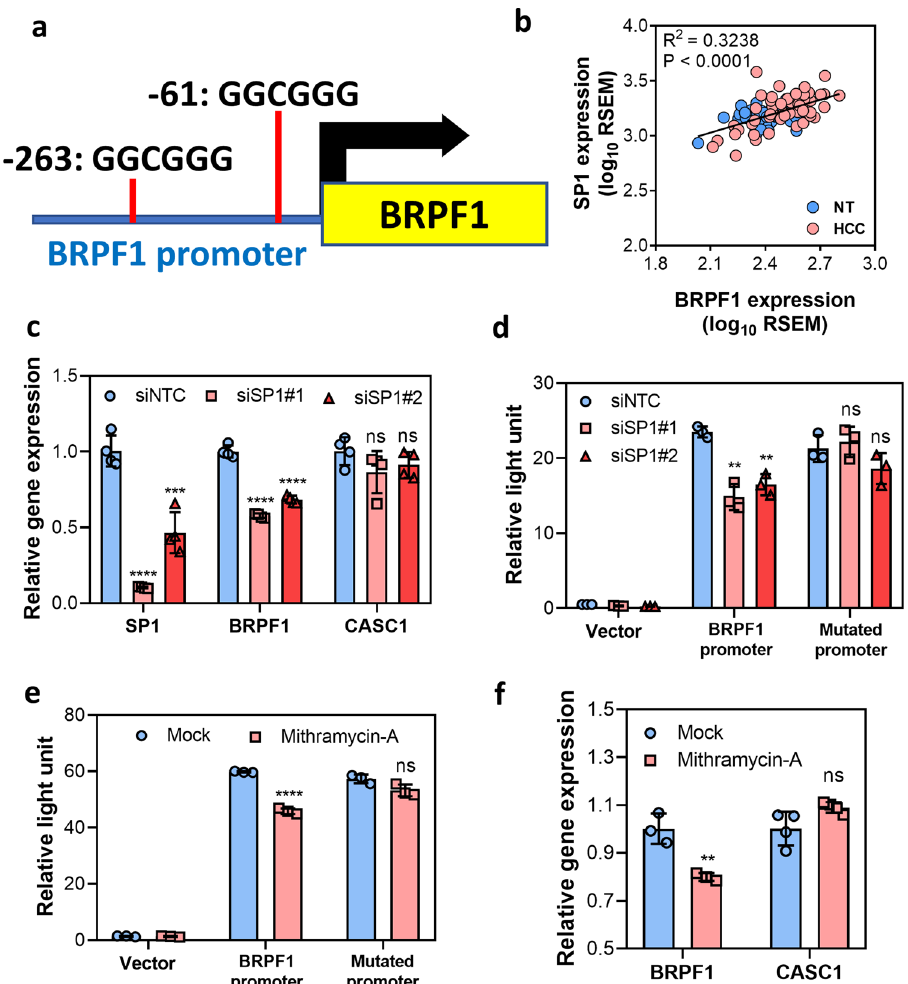
Fig. 3 SP1 upregulation facilitated the increase in BRPF1 expression. a The BRPF1 promoter contains two SP1 putative binding sites. b The expression of SP1 was positively correlated with the expression of BRPF1 in TCGA HCC cohort ( R 2 = 0.3238, P < 0.0001, linear regression, n = 50). c Inactivation of SP1 by siSP1 reduced the mRNA expression of BRPF1 and SP1 in HEK293T cells, while the expression of CASC1, a non-SP1 target, remained unchanged. d Treatment with siSP1 decreased BRPF 1 promoter activity, but not the activity of SP1 binding site mutated BRPF1 promoter in HEK293T cells. e 20 nM mithramycin A, a SP1 inhibitor, reduced BRPF1 promoter activity in HEK293T cells after 48-h treatment. f 20 nM mithramycin A reduced the mRNA expression of BRPF1 in MHCC97L after 48-h treatment. Error bars indicate mean ± SD. Data were compared by independent t -test unless indicated otherwise. Results were repeated at least three times. ** P < 0.01, *** P < 0.001, **** P < 0.0001, ns not signi fi cant vs. mock or siNTC as Upon 48-h treatment with mithramycin A, the mRNA expression of BRPF1 in MHCC97L was signi fi cantly reduced (Fig. 3f). The above fi ndings collectively suggested that overexpression of SP1 contributed to BRPF1 upregulation in human HCC.